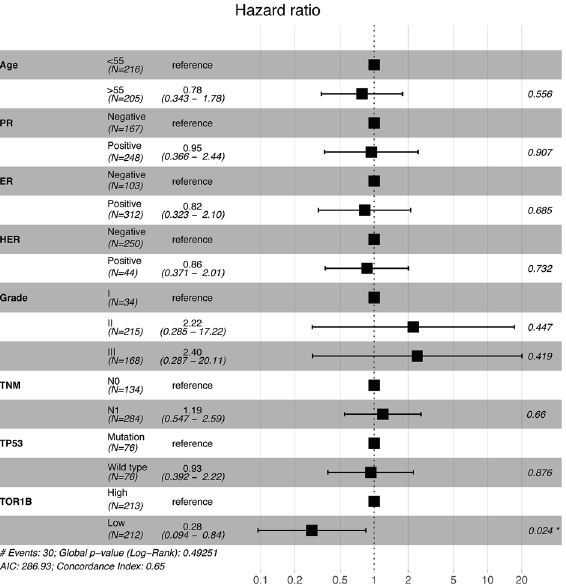
Figure 6. Multivariate Cox proportional hazard regression analyses of TOR1B and other clinical information.